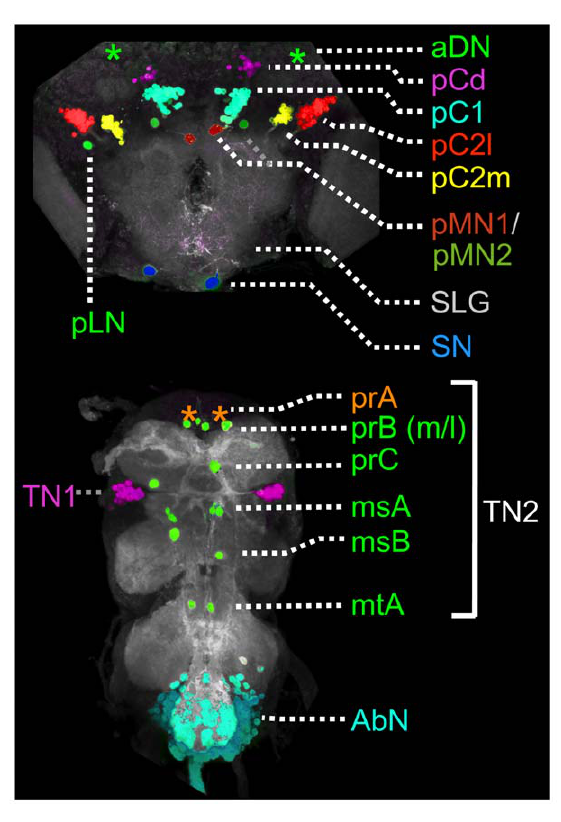
Figure 7. Diagram of dsx GAL4 expression in the CNS. Identity of neurons and neuron clusters expressing dsx GAL4 in the male brain and VNC are diagrammed following the nomenclature of Lee et al. [26] with several additions. Positions of neurons not visible in this projection are represented by asterisks based on their position in other samples. In the brain, we observed the following previously identified neurons: anterior dorsal neurons (aDN, not visible in this projection), posterior clusters pC1 and pC2, and the suboesophageal neurons (SN). We subdivide pC2 into lateral and medial clusters (pC2l and pC2m, respectively) based on their projections. We add the posterior dorsal cluster (pCd) and identify two distinctive posterior Medial Neurons (pMN1 and pMN2) near cluster pC1, as well as one isolated posterior Lateral Neuron (pLN) within each hemibrain. The pMN neurons are also identifiable in females. We did not observe the Suboesophageal Lateral Neurons (SLNs) reported by Lee et al. [26] but instead note a dispersed population of putative glia in the anteroventral optic cleft (see Figure 8). In the VNC, we observe the previously identified prothoracic TN1 neurons and several single and paired thoracic TN2 neurons. We distinguish the latter by their segmental identity as prothoracic (pr), mesothoracic (ms), or metatho- racic (mt) TN2 neurons; prA (not visible in this sample) resides on the dorsal cortex of the VNC, while the rest are found ventrally. We also distinguish the prB TN2 neurons as medial (prBm) and lateral (prBl) neurons. The abdominal cluster (AbN) is also visible in both males and